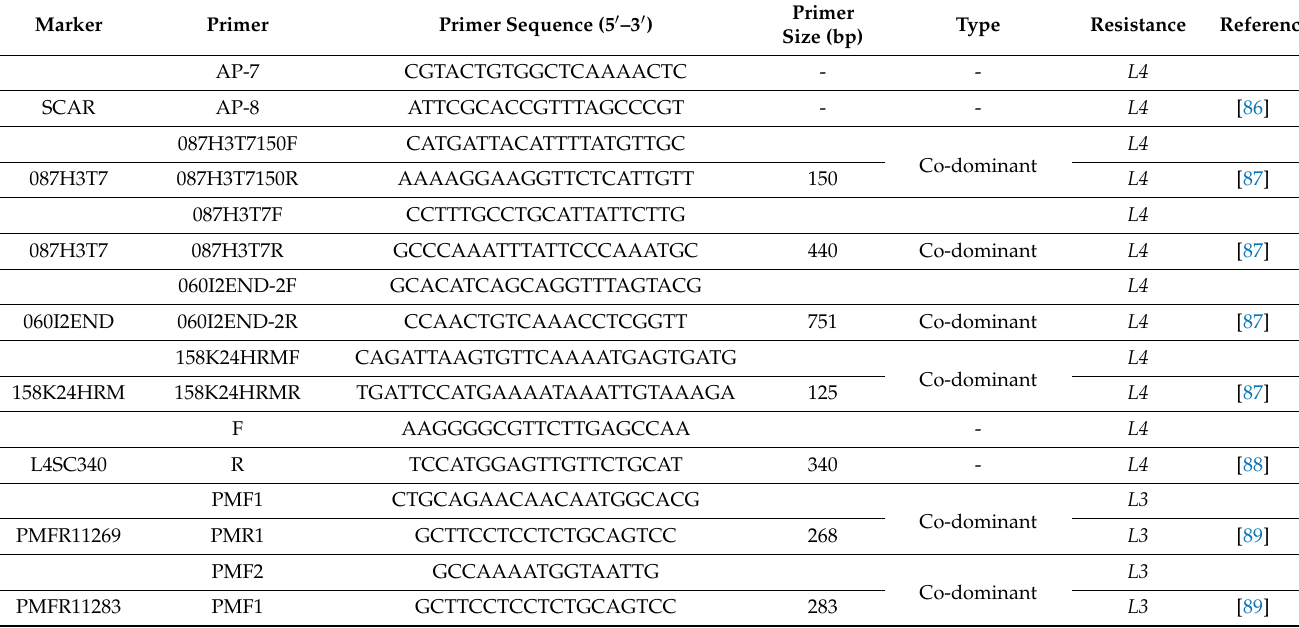
Table 3. DNA markers used in the genotype selection of PMMoV-resistant pepper accessions.